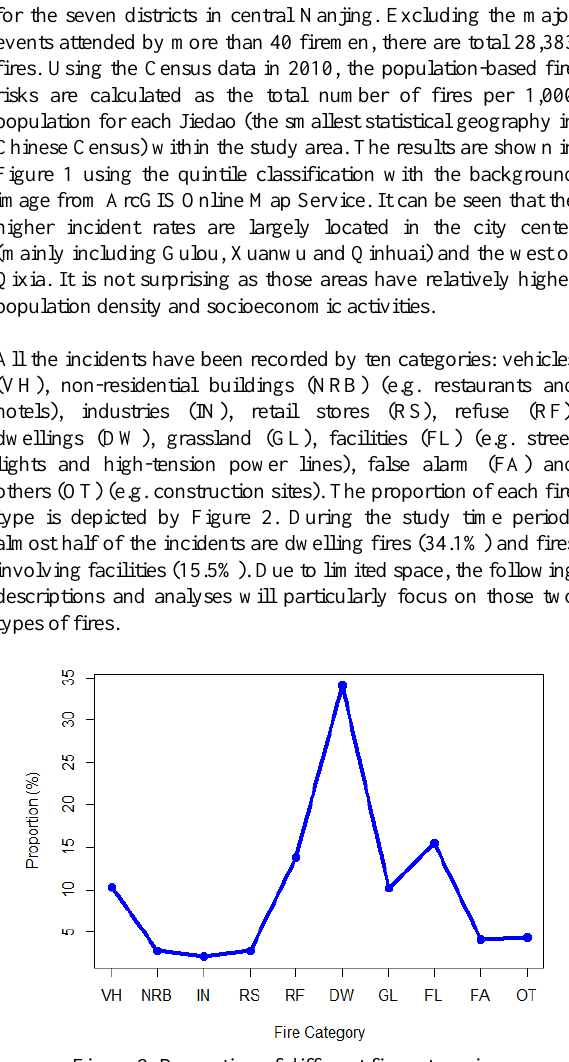
Figure 2. Proportion of different fire